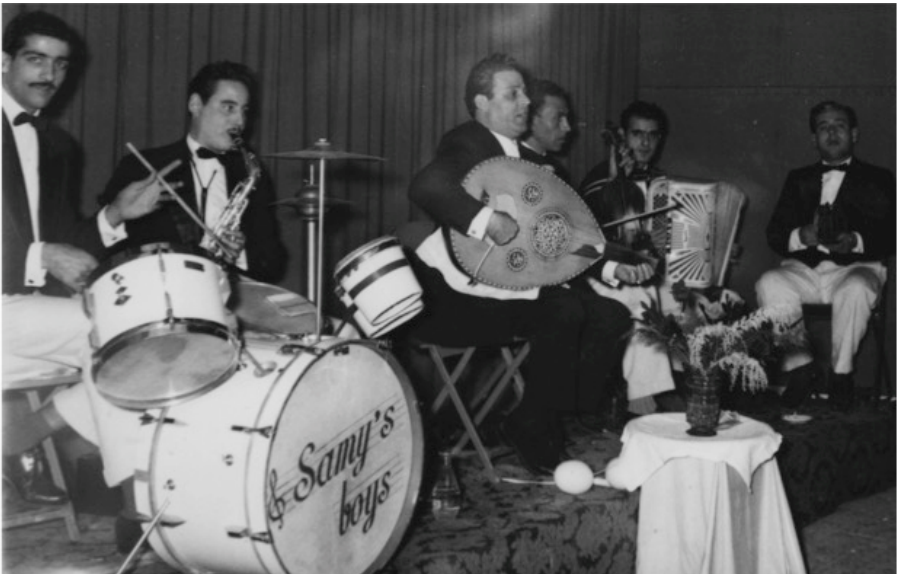
Figure 1. Samy’s Boys in Concert in the early 1950s (Courtesy of Yolande Amzallag, Foundation Samy Elmaghribi).